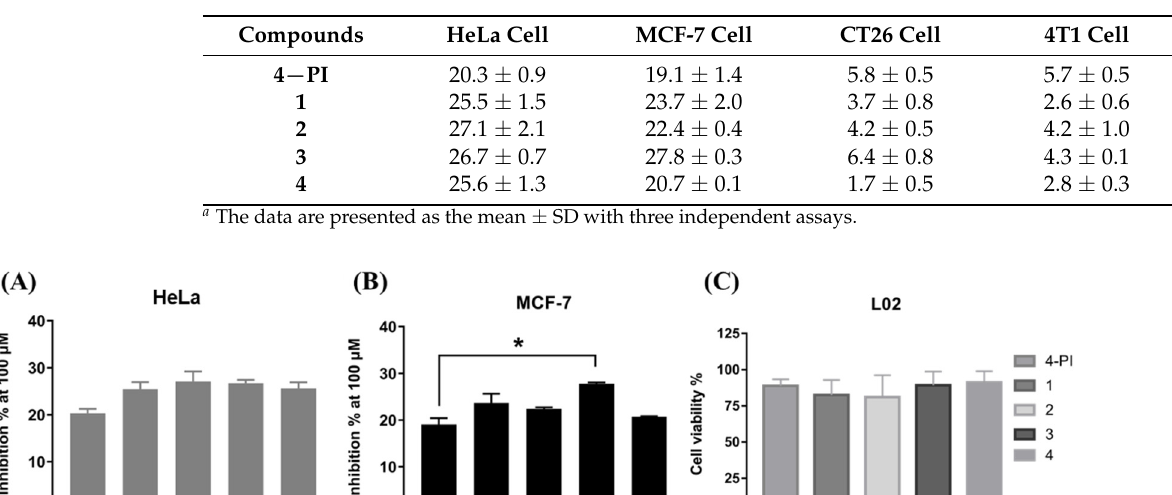
Table 1. Inhibitory activity of spiro-oxindole skeleton compounds against IDO1 and determination of inhibition types. a .